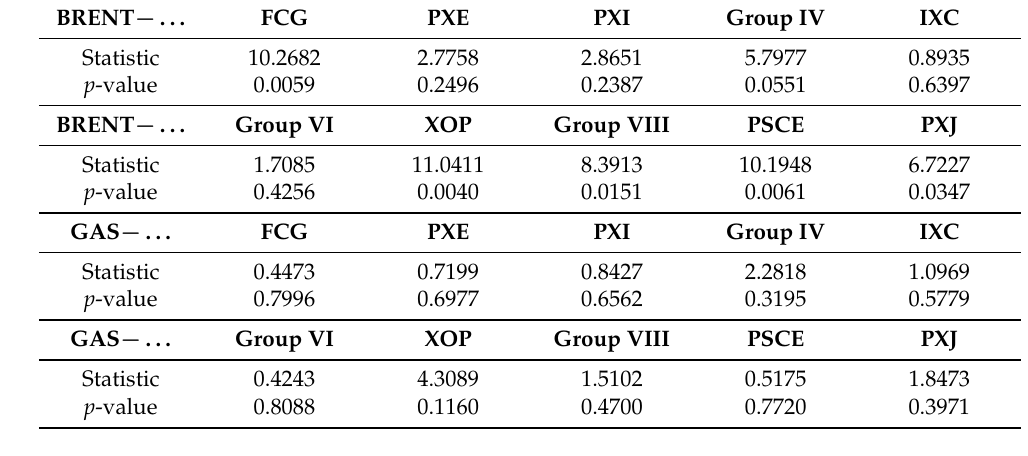
Table 3. Tests of non-constant correlation.